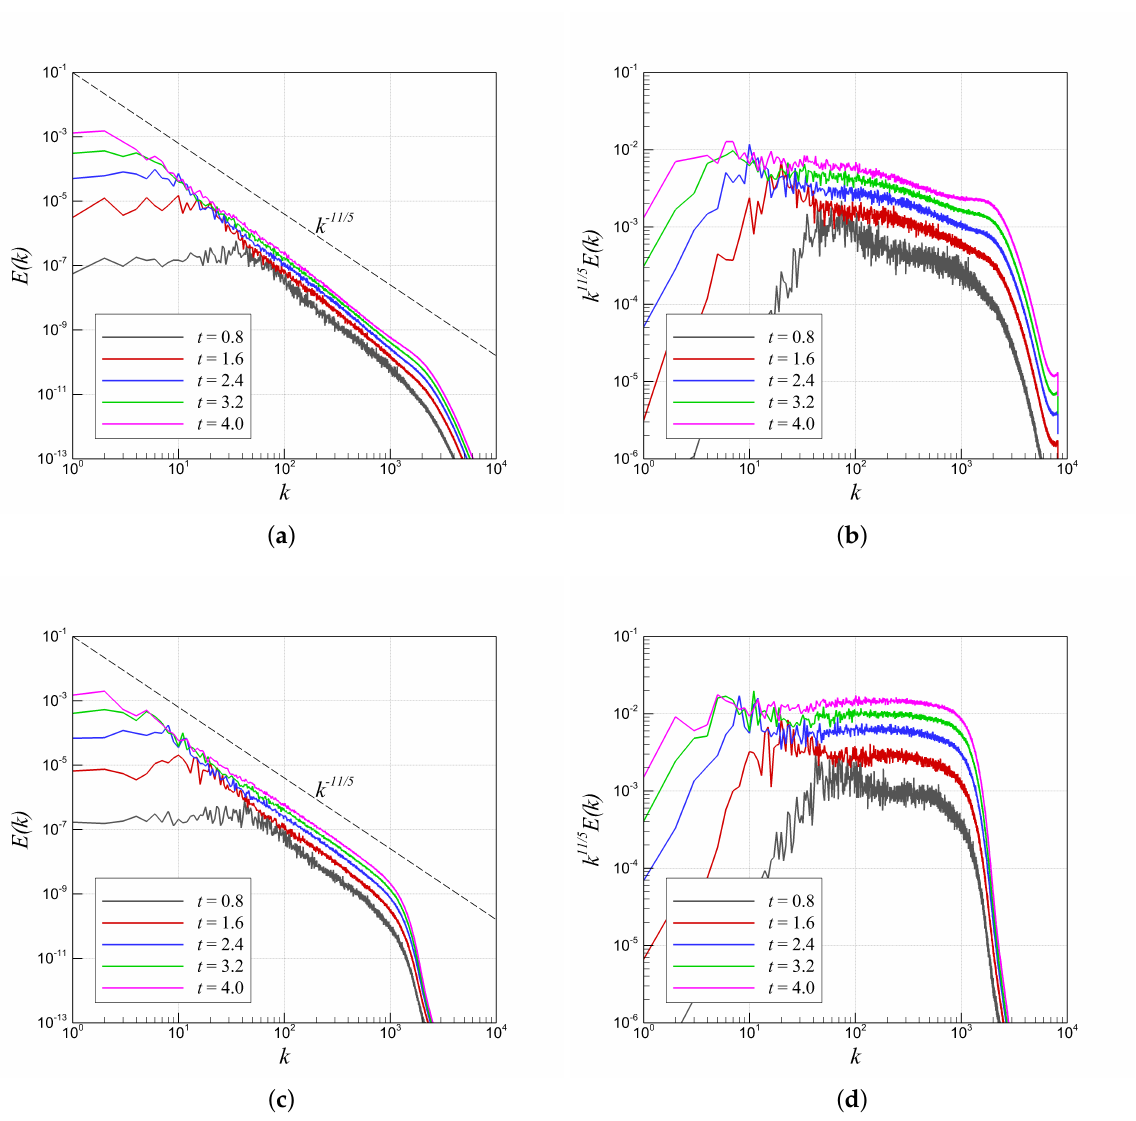
Figure 6. Time evolution of density-weighted kinetic energy spectra and compensated density- weighted kinetic energy spectra for the RTI problem with multi-mode perturbation obtained using different modeling approaches at a resolution of 16384 × 24576; ( a ) density-weighted spectra using ILES-Roe solver; ( b ) compensated density-weighted spectra using ILES-Roe solver; ( c ) density-weighted spectra using CS+RF ( σ = 1.0) solver; ( d ) compensated density-weighted spectra using CS+RF ( σ = 1.0)